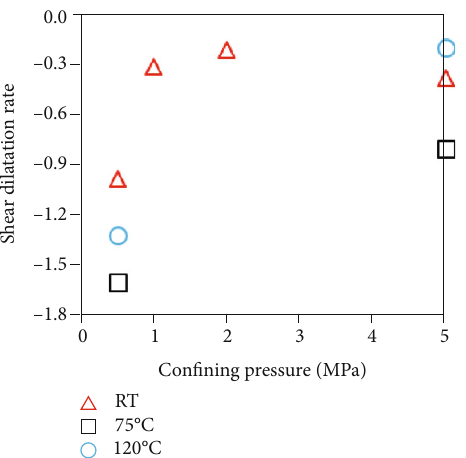
Figure 8: Characteristics of the oil sand shear dilatation rate under di ff erent con fi ning pressures and temperatures.